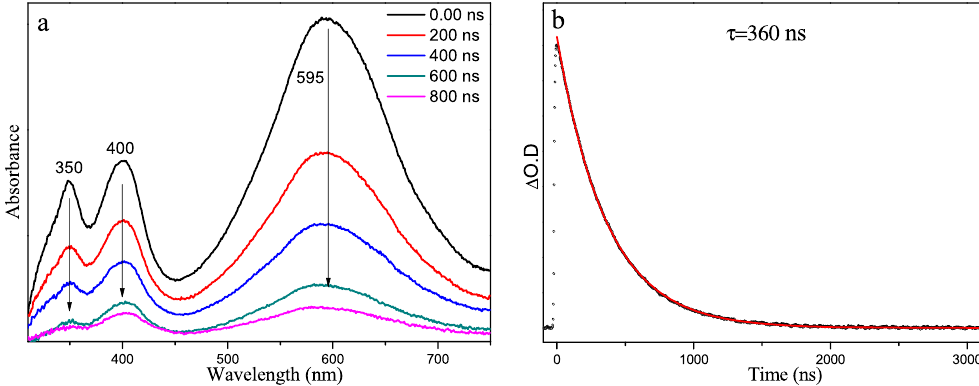
Figure 5. ( a ) The ns-TA spectra and ( b ) the temporal dependence of the transient absorption at 590 nm for PPAQ in MeCN are shown.